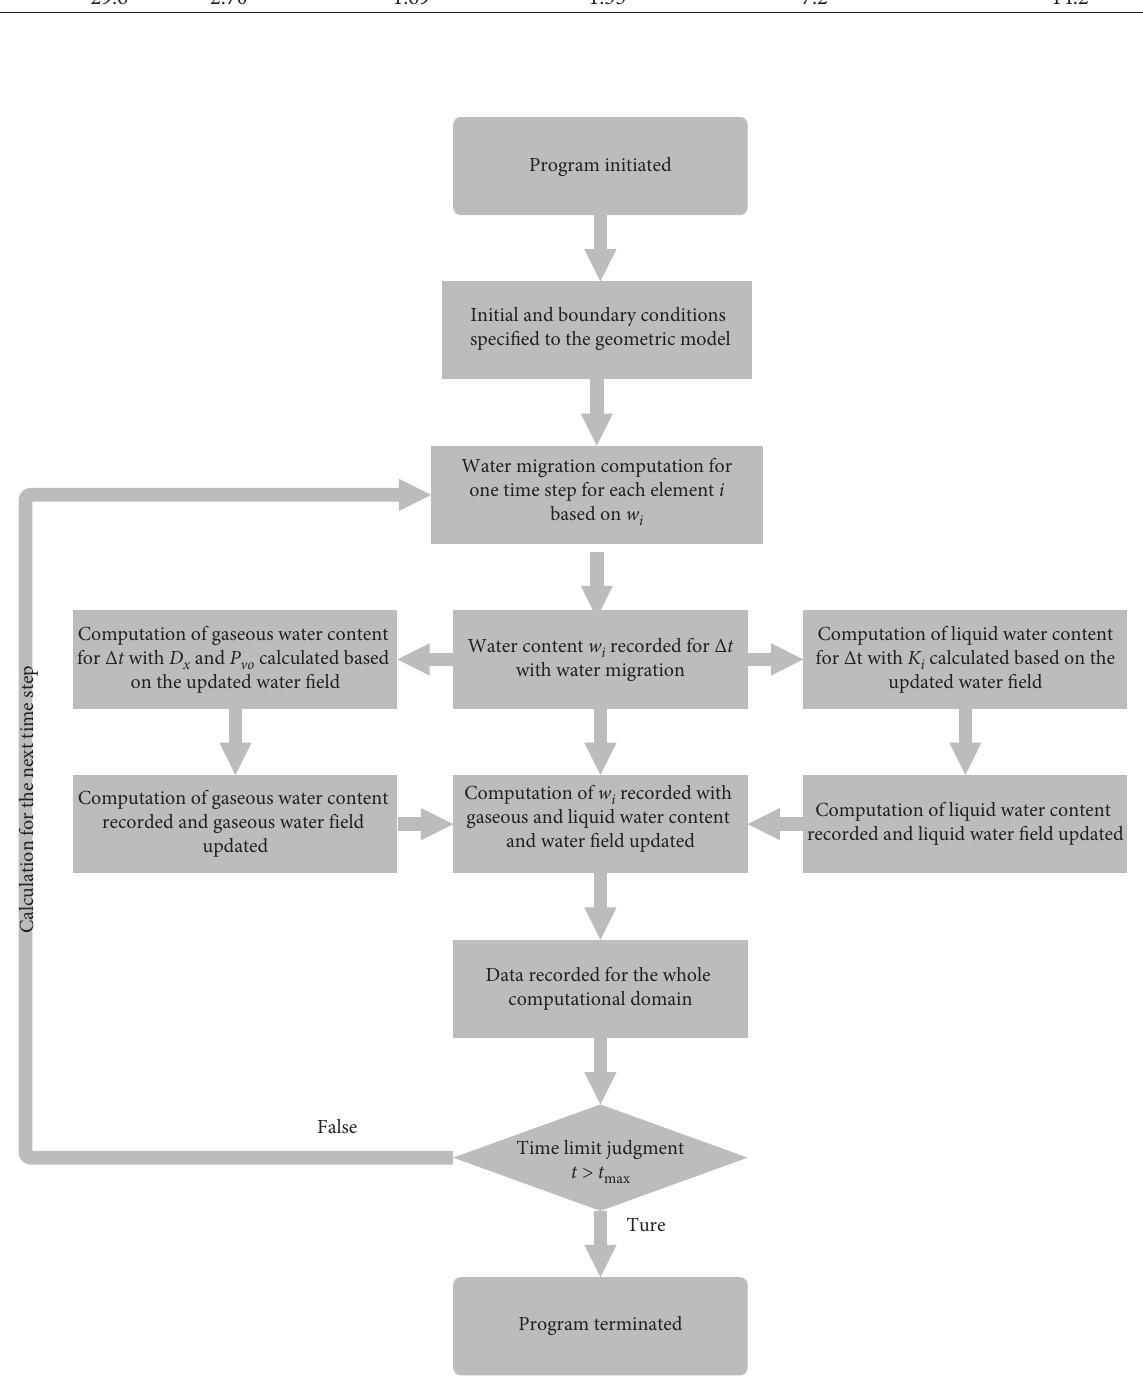
Figure 8: Computational procedure.